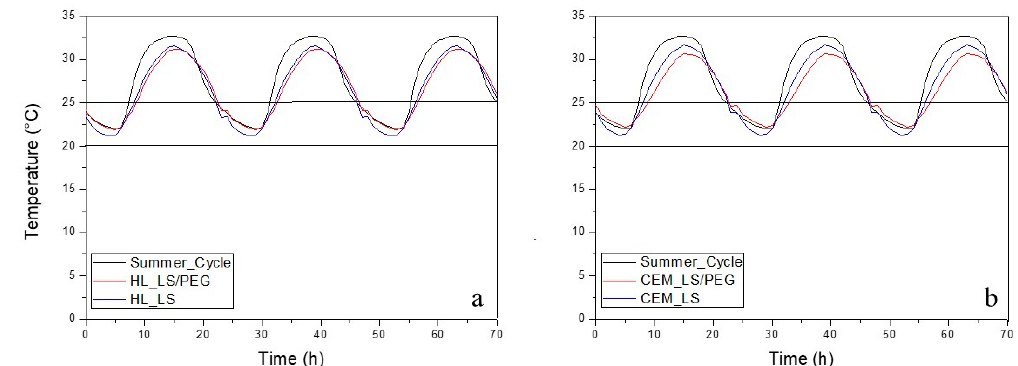
Figure 5. Thermal behavior in summer of the developed mortars: ( a ) hydraulic lime-based mortar and ( b ) cement-based mortar. The thermal comfort zone is between 20–25 °C.